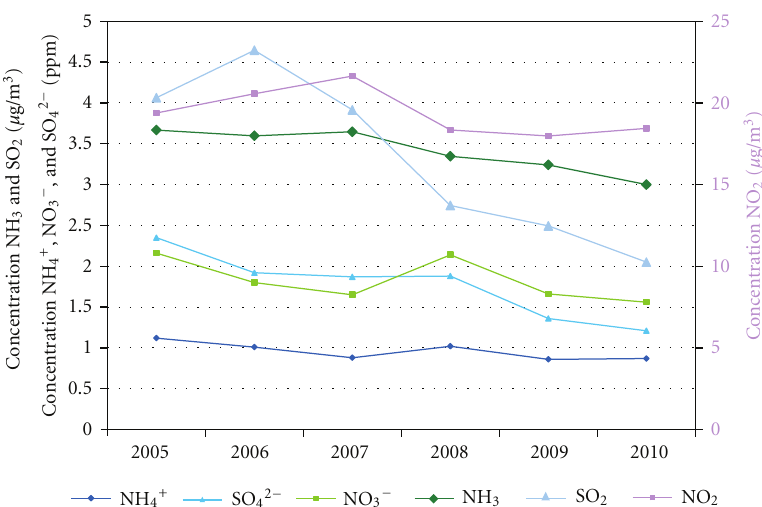
FIGURE 3: Average concentrations of acidifying pollutants between 2005 and 2010 across Flanders. NH 3 and SO 2 are decreasing, NO 2 is stable, and all the other pollutants have decreasing concentrations throughout the whole period.